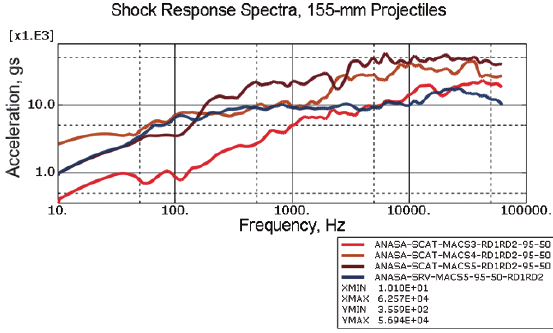
Fig. 13. Comparison of normal tolerance limits, MACS 3, 4 and 5; axial, Q = 10. (Note: The red curve is the SRS for the near-tactical MACS 5 shots).